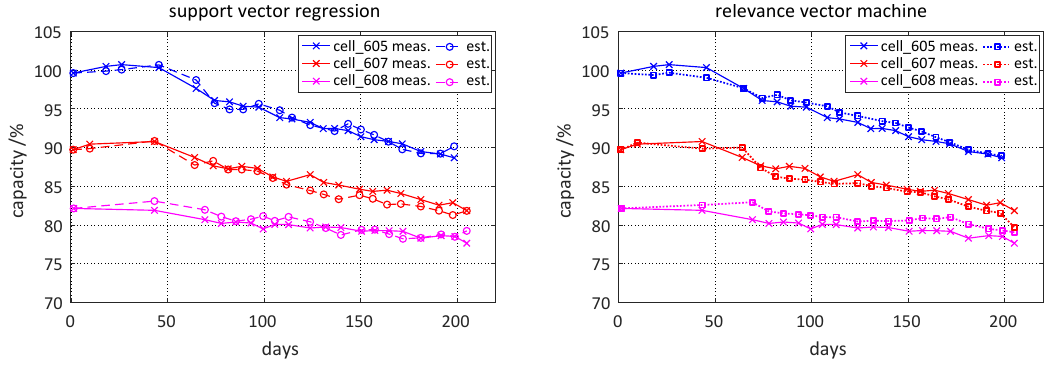
Figure 12. Incremental model results when the initial batch model is updated iteratively on the same data set containing cells of different